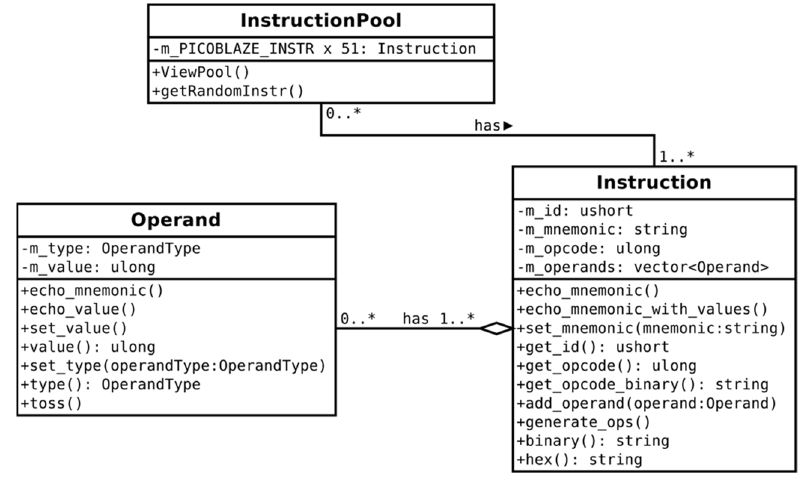
Figure 16. C++ classes for randomly generating PicoBlaze instructions.